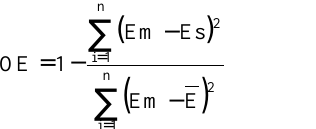
variáveis de 0,92 significativo a 1 %.